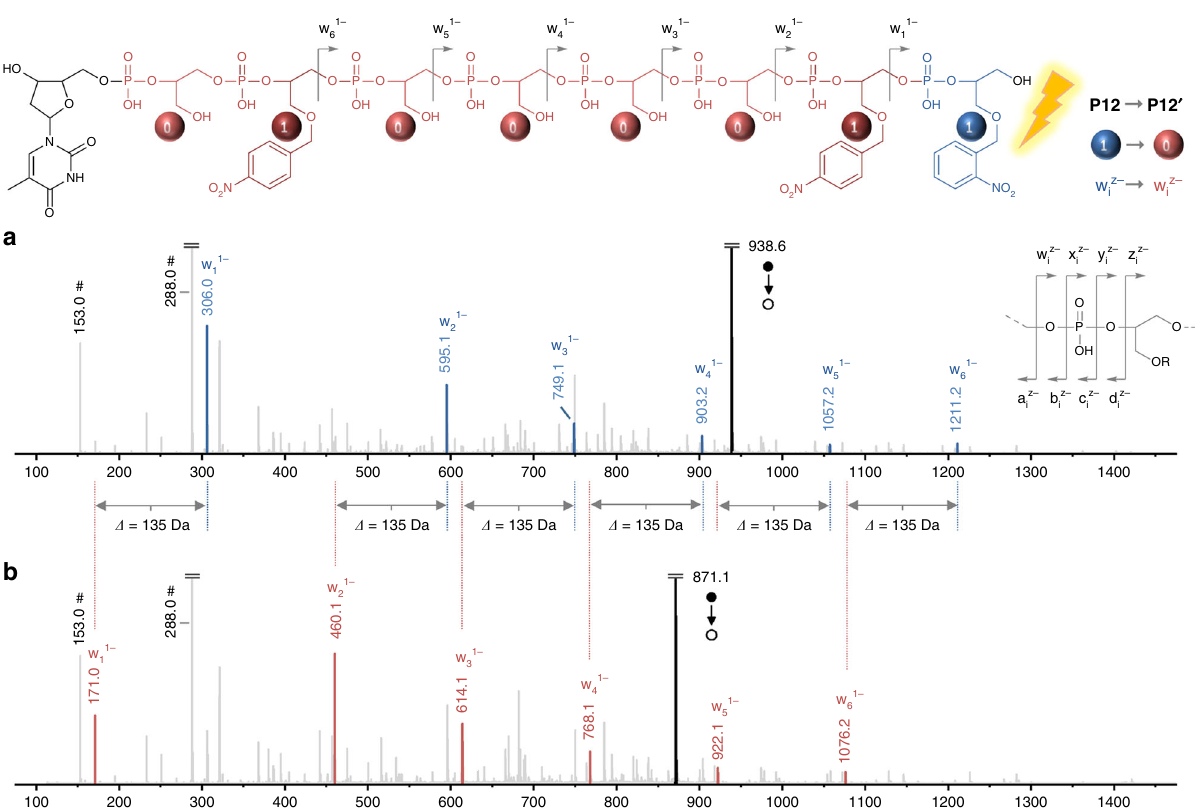
Fig. 4 Photo-induced sequence mutation. MS/MS sequencing spectra obtained for polymer P12 before ( a ) and after ( b ) light exposure. The top and bottom spectra were obtained by collision-induced dissociation of the [ P12 -2H] 2 − and [ P12 ′ -2H] 2 − precursor ions, respectively. In these conditions, a phosphate repeat unit leads to different fragments, as indicated by the gray fragmentation pattern on the right side of panel a . However, for clarity, only w i z − fragments are highlighted in this fi gure. The corresponding peaks were intentionally thickened and colored (blue before- and red after irradiation) with the help of the Origin software. All other fragments are intentionally displayed in light gray. A detailed interpretation of all peaks can be found in Supplementary Table 6. Black hashtags indicate deprotonated repeat units at m/z 153.0 and m/z